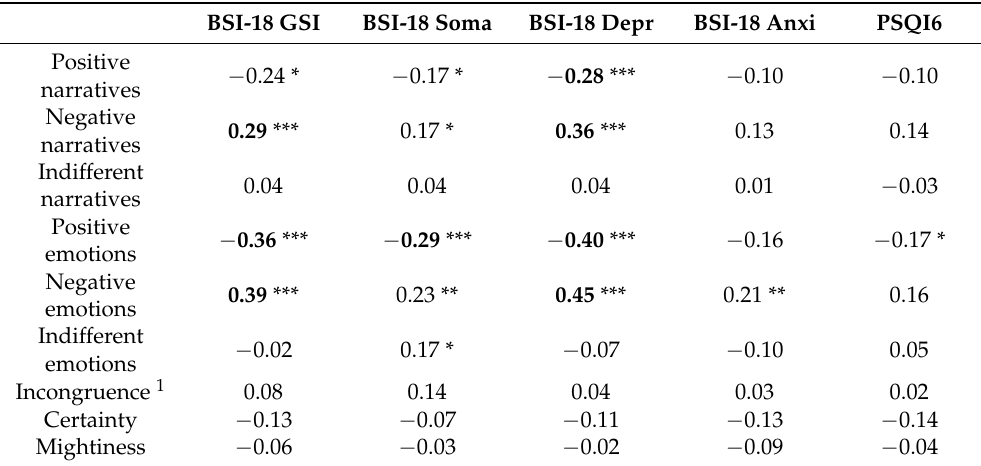
Table 4. Bonferroni-adjusted partial correlations between the credition parameters and the psychiatric